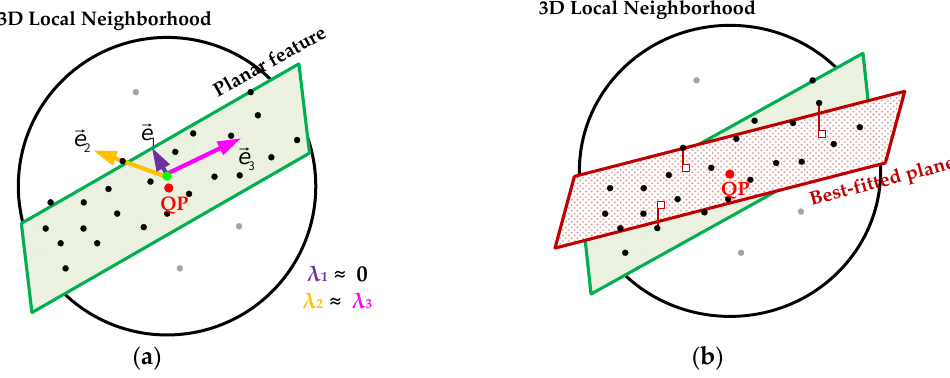
Figure 2. Established local neighborhood for ( a ) the detection and ( b ) precise representation of planar features (through iterative plane fitting procedure).